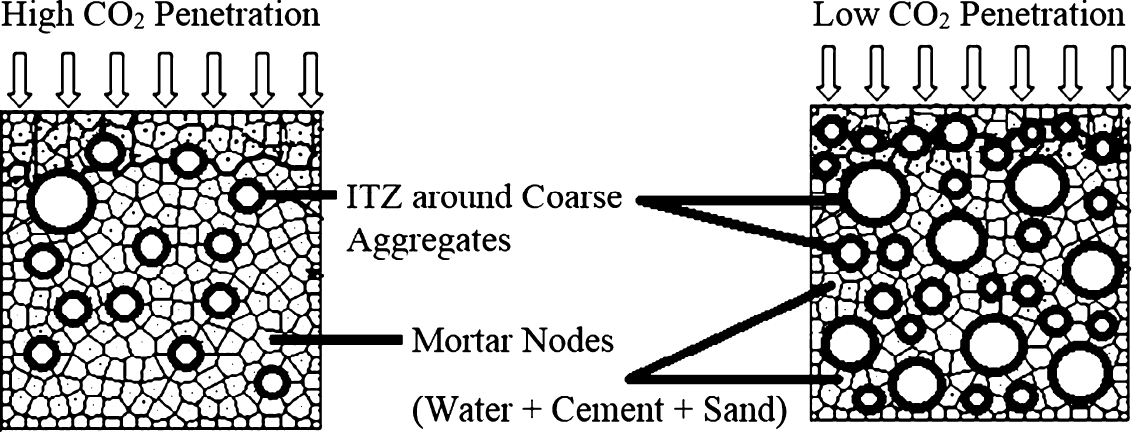
Figure 2. The effects of mortar and coarse aggregate contents on a concrete mixture’s carbonation resistance [16].